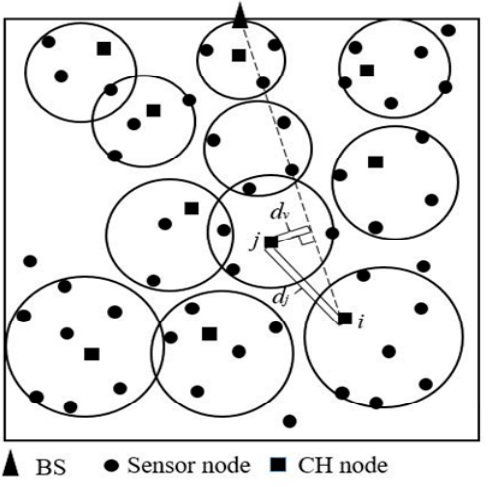
Figure 12. Schematic diagram of inter-cluster routing.